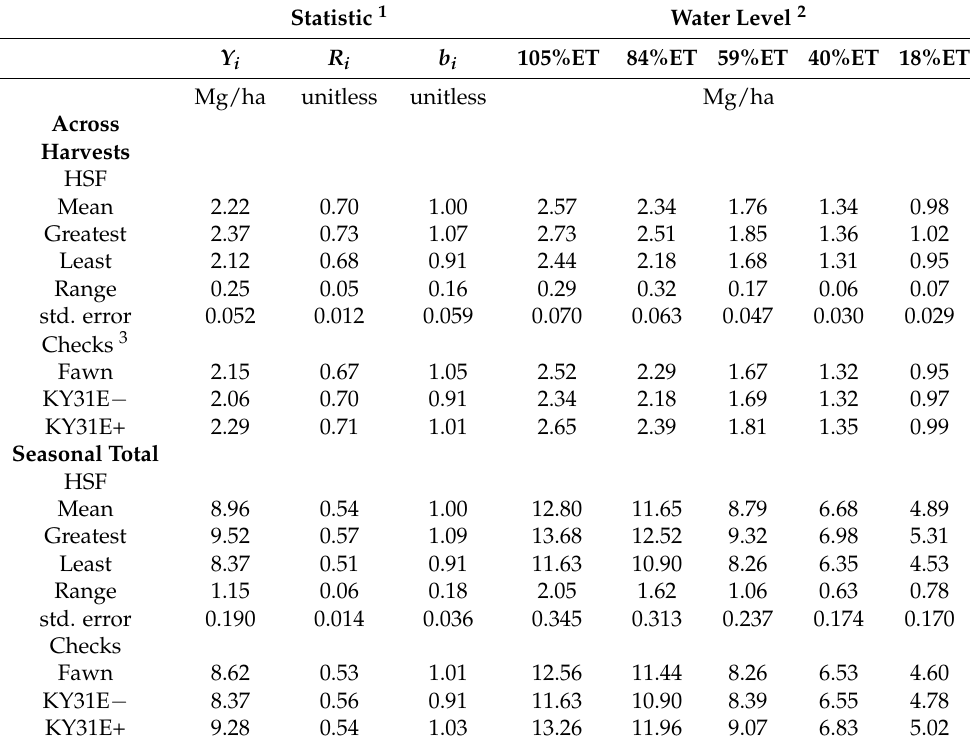
Table 2. Range and mean of BLUP values for forage mass based upon five harvests per season or the seasonal total of 28 tall fescue half-sib families (HSF) and 3 cultivar checks evaluated in a line-source irrigation experiment with 5 water (WL) levels from 2001 to 2003 near Logan, UT,